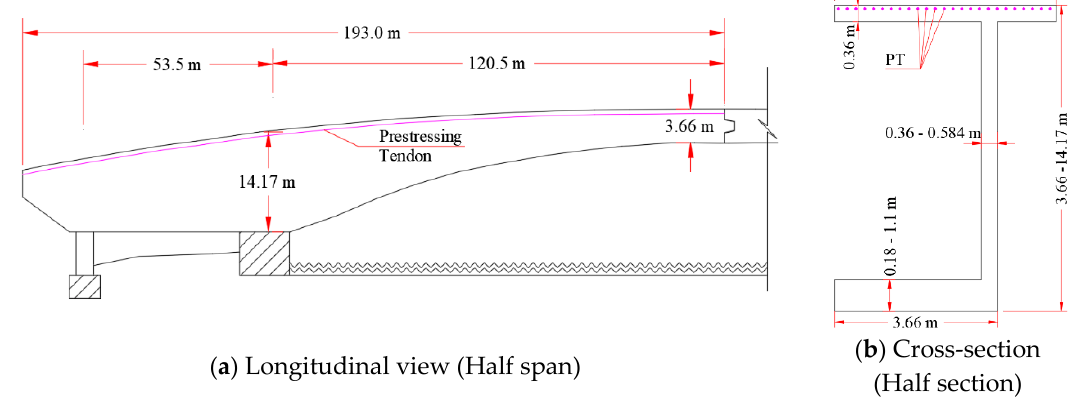
Figure 16. Longitudinal and cross-sectional view of Koror–Babeldaob Bridge [28].